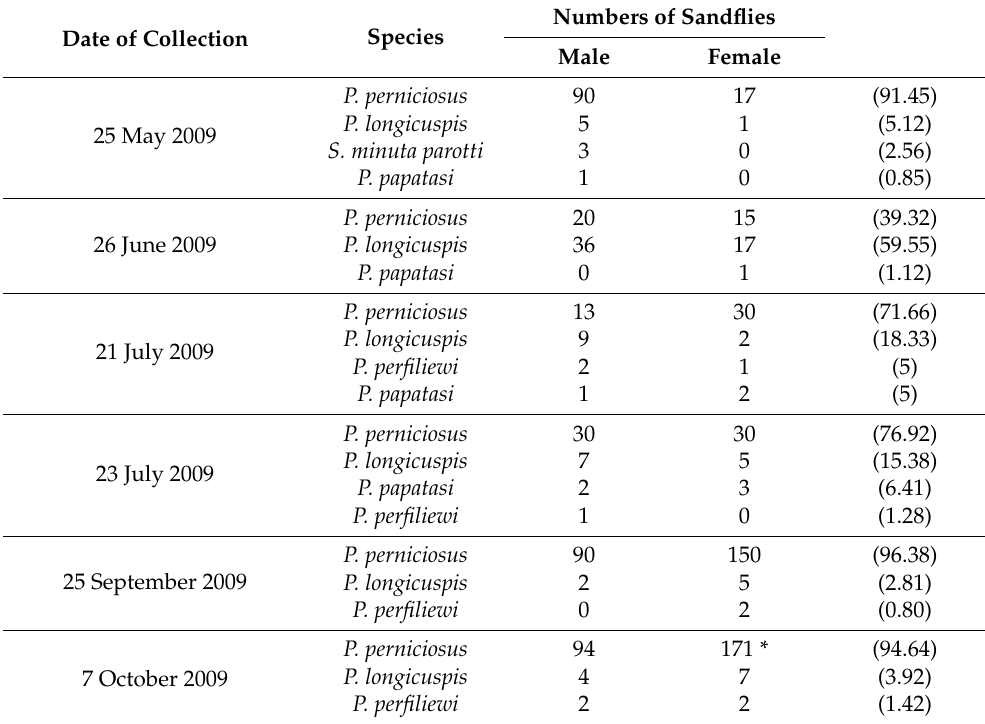
Table 2. Composition sandflies collected from Utique during 2009 according to date of collection, species, sex, and number (%) of specimens investigated for the presence of